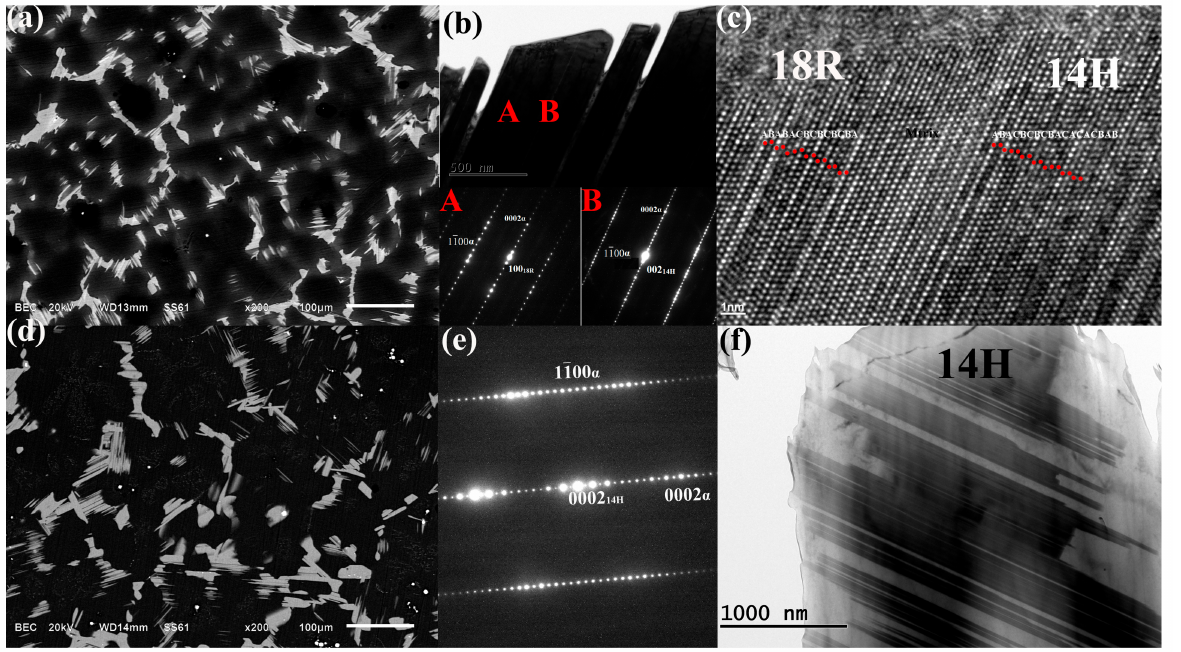
Figure 1. Microstructure for as-cast alloy: ( a ) SEM image; ( b ) bright-field image of the long period stacking ordered (LPSO) phase and corresponding SAED pattern for zones A and B taken along microscopy (HRTEM) image for LPSO in Figure 1b taken along the alloy: ( d ) SEM image; ( e ) SAED pattern for the LPSO phase taken along the bright-field image for the LPSO